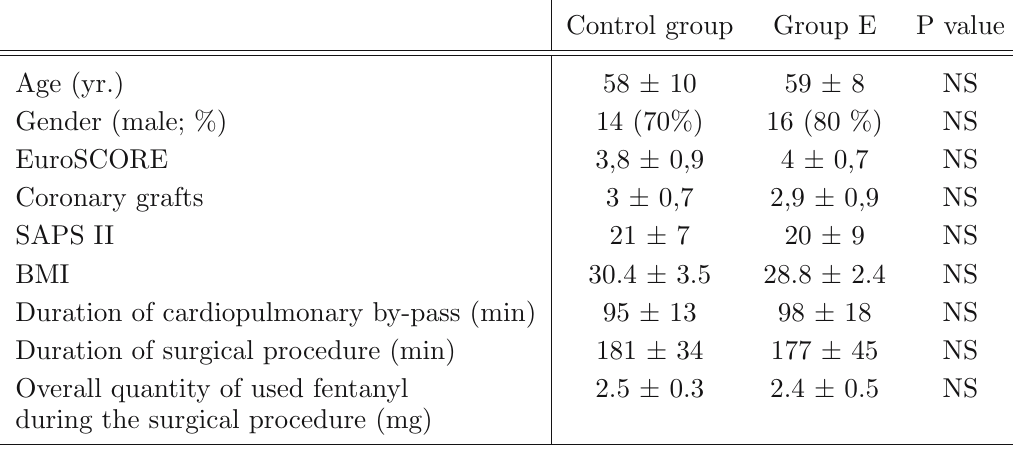
Table 1 The age, gender, number of coronary grafts, EuroSCORE, severity of illness (SAPS II), body mass index (BMI), duration of cardiopulmonal by-pass and